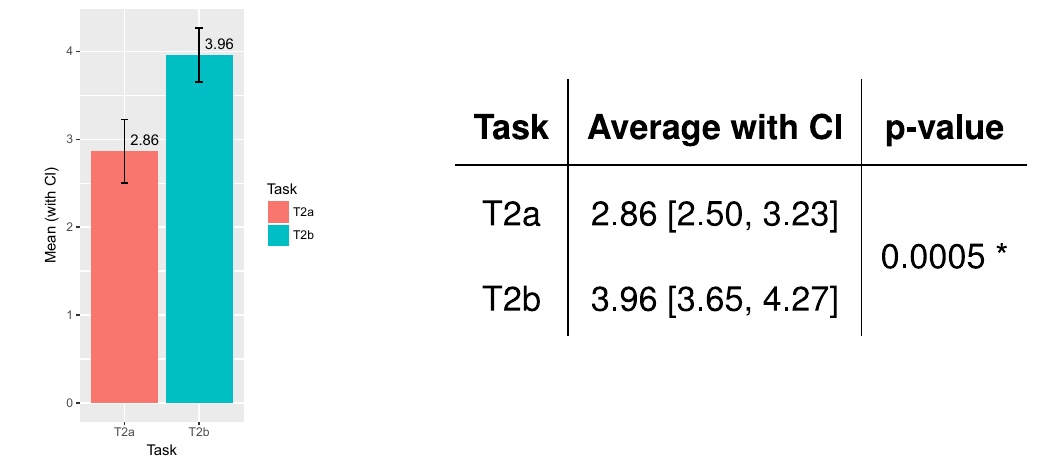
Figure 9: SEQ analysis, for acufenometry, old (T2a) and new (T2b) versions.